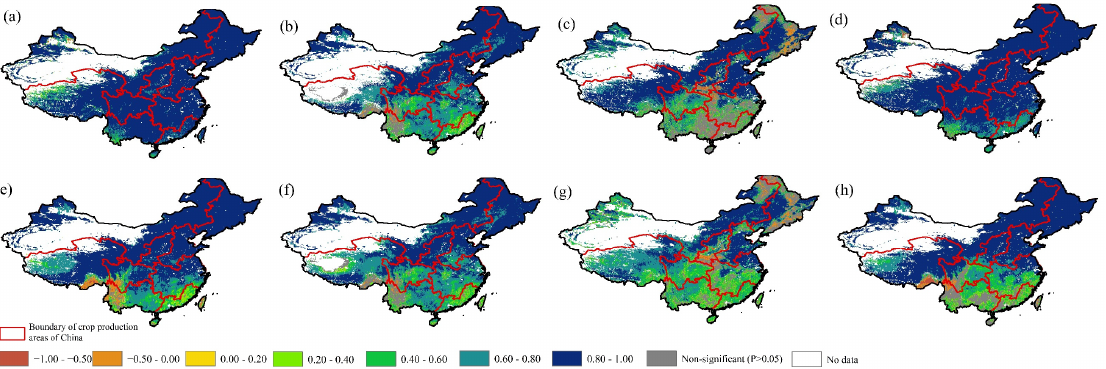
Figure 4. Spatial distributions of the correlations between GPP and SIF ( a . growing season; b . spring; c . summer; and d . autumn) and between GPP and NDVI ( e . growing season; f . spring; g . ( b ) spring; ( c ) summer; and ( d ) autumn) and between GPP and NDVI (( e ) growing season; ( f ) summer; and h . autumn). spring; ( g ) summer; and ( h )